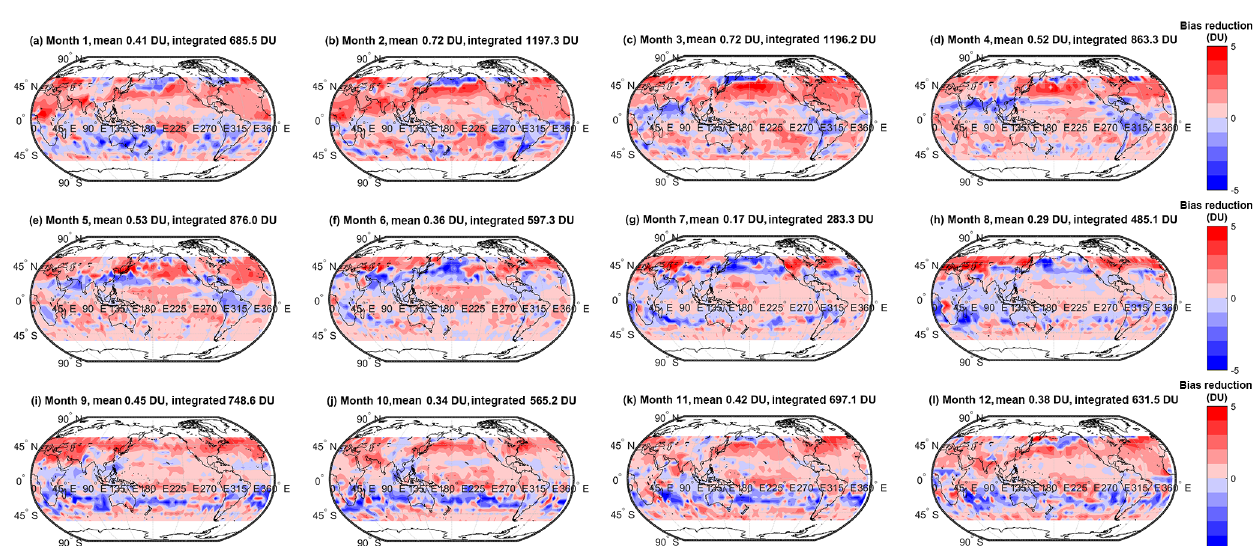
Figure 7. Monthly bias reduction (DU) defined as the difference in the absolute bias between the cluster-based MMM ozone column and observations, and the simple arithmetic MMM and observations. Where the bias reduction is positive (i.e. red) the cluster-based MMM values are closer to the observations than the simple arithmetic MMM. In the title of each panel, the global mean absolute bias reduction, and the absolute bias reduction summed over all grid cells are